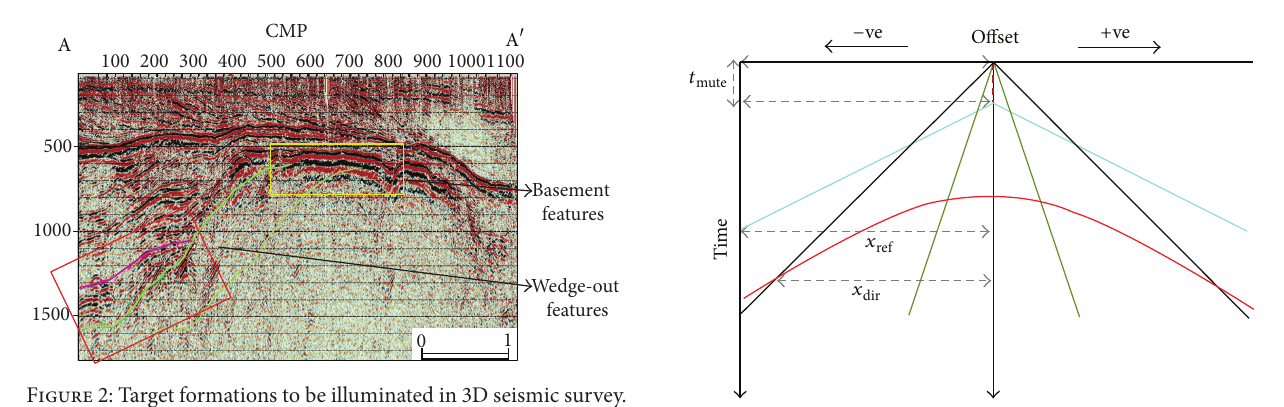
Figure 2: Target formations to be illuminated in 3D seismic survey.